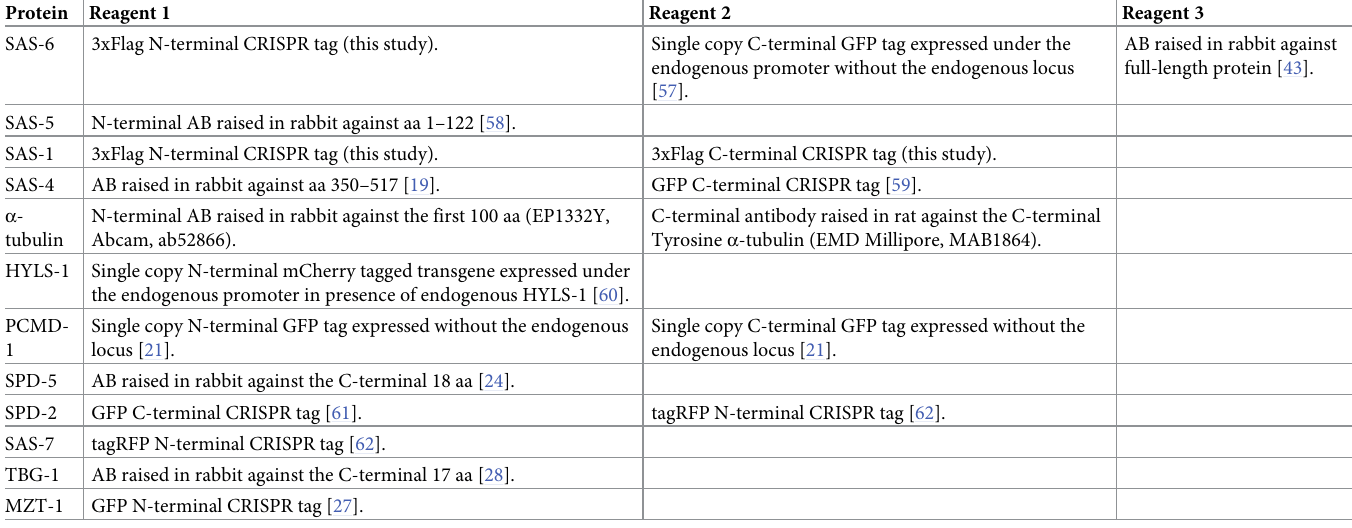
Table 1. List of reagents to detect centriolar